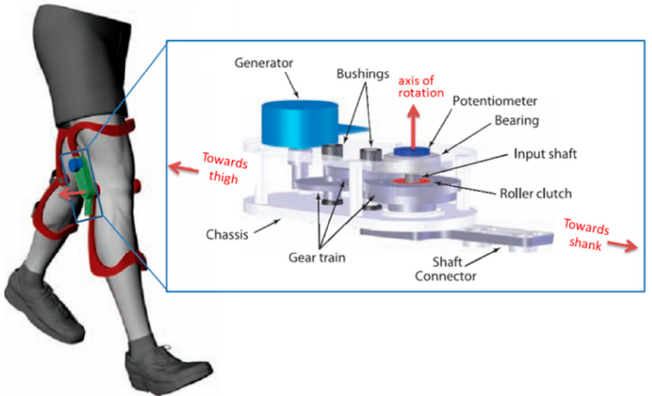
Figure 6. Energy harvester mounted on orthopedic knee brace [66].